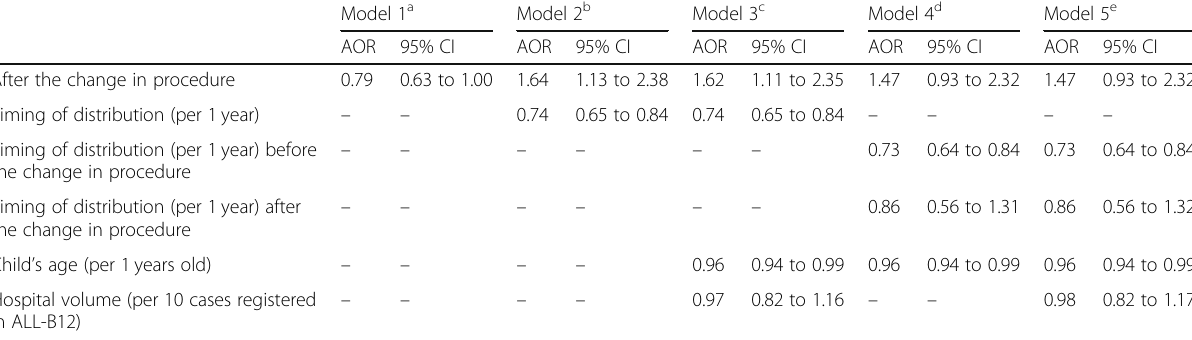
Table 1 Estimated effect on response to QOL questionnaire ( N = 1767)